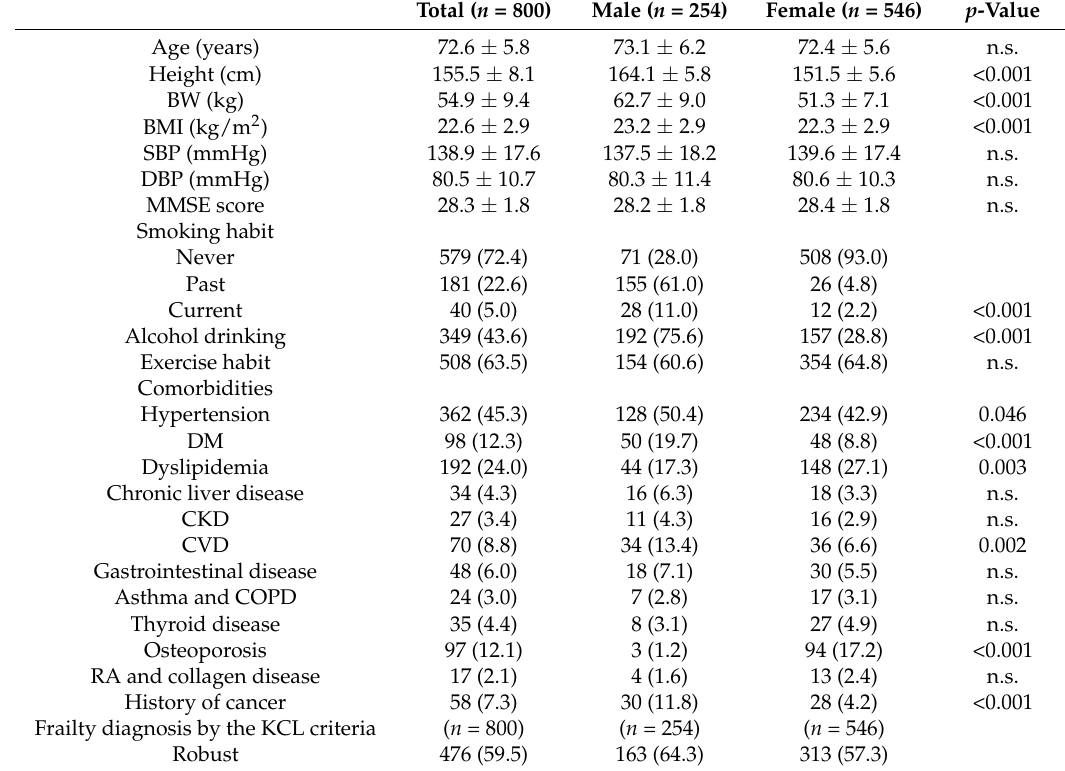
Table 1. Basic characteristics and the diagnosis of frailty in the 800